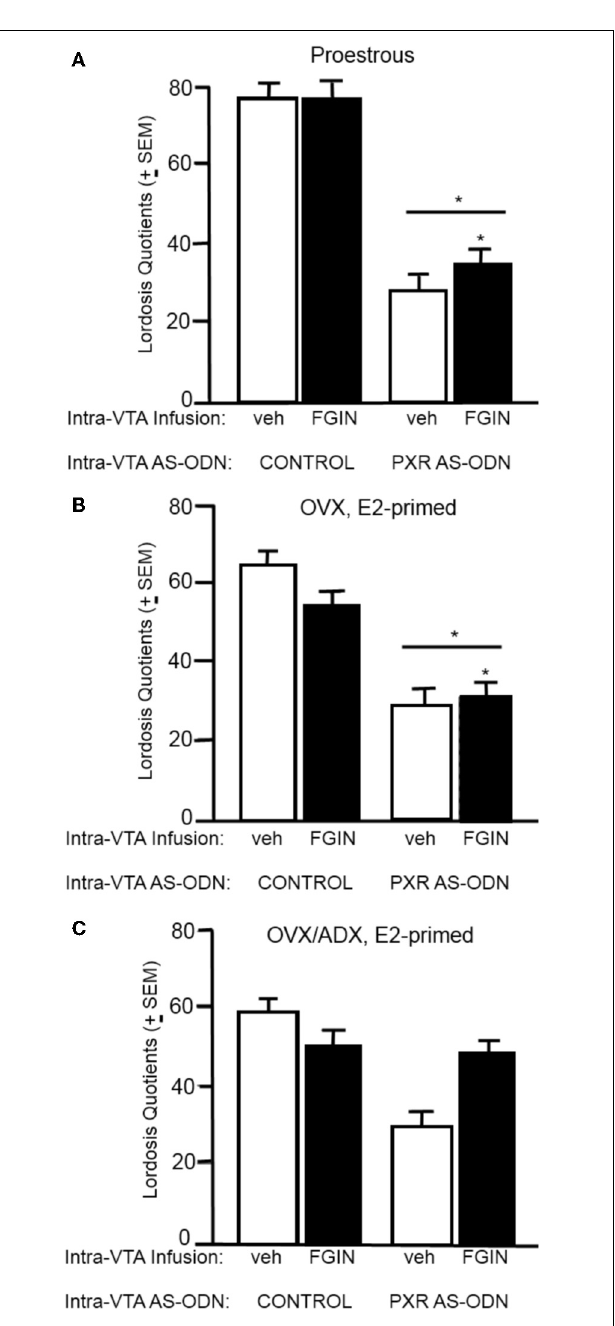
FIGURE 4 | (A) Depicts the mean ( ± s.e.m.) lordosis quotients of proestrous rats infused with control and vehicle (veh, n = 15), control + FGIN ( n = 15), pregnane xenobiotic receptor (PXR) antisense deoxynucleotides (AS-ODNs) + vehicle ( n = 8), or PXR AS-ODN + FGIN ( n = 13) in Experiment 2. (B) Depicts the mean ( ± s.e.m.) lordosis quotients of ovariectomized (OVX) estradiol (E2)-primed rats infused with control + veh ( n = 8), control + FGIN ( n = 7), PXR AS-ODN + veh ( n = 7), or PXR AS-ODN + FGIN ( n = 6) in Experiment 3. (C) Depicts the mean ( ± s.e.m.) lordosis quotients of OVX/adrenalectomized (ADX), E2-primed rats infused with control + veh ( n = 9), control + FGIN ( n = 5), PXR AS-ODN + veh ( n = 8), or PXR AS-ODN + FGIN ( n = 5) in Experiment 4. ∗ above a line indicates a significant effect of PXR AS-ODNs compared to control. ( P < 0 .